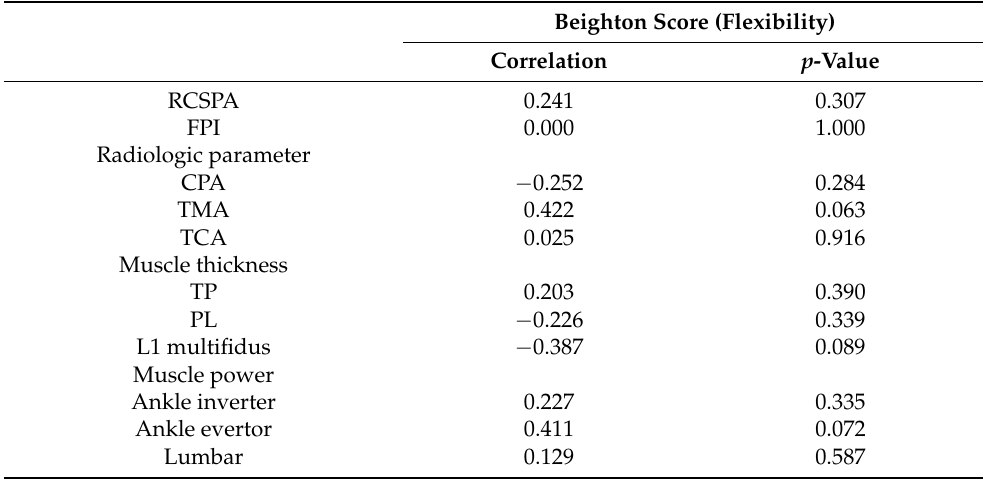
Table 9. Correlation between Beighton score and RCSP, FPI, radiologic parameters, muscle thickness, and muscle power of flatfoot for male participants (n =